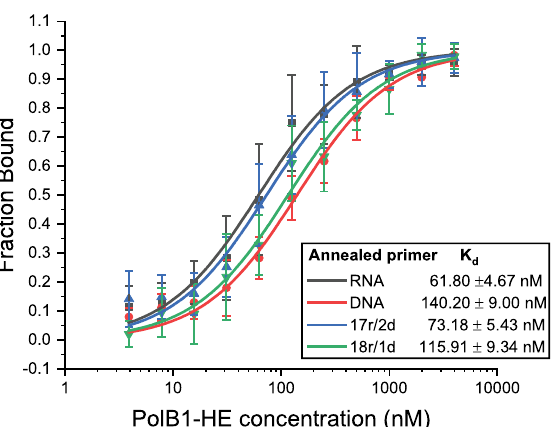
Fig. 2 DNA-synthetic mode PriSLX stimulates RNA-primer extension. a – c Primer elongation reactions with 100 µ M dNTPs; 25 nM 5 ′ -cy5-labeled primer as indicated annealed to 80 nt template; PolB1-HE titration (25, 12.5, 6.25 nM) as indicated; 25 nM PriSLX as indicated; and PriSLX PD (Polymerase Dead) as indicated. Reactions were incubated for 5 min at 75 °C prior to termination and electrophoresis on denaturing polyacrylamide gels. Three independent replicates of this experiment were performed. d K d determination by fl uorescence polarization. Titration series of PolB1-HE as indicated with indicated 5 ′ -Cy5-labeled primer annealed to 80 nt template. Data points indicate the mean value and error bars represent standard deviation. Four independent replicates of this experiment were